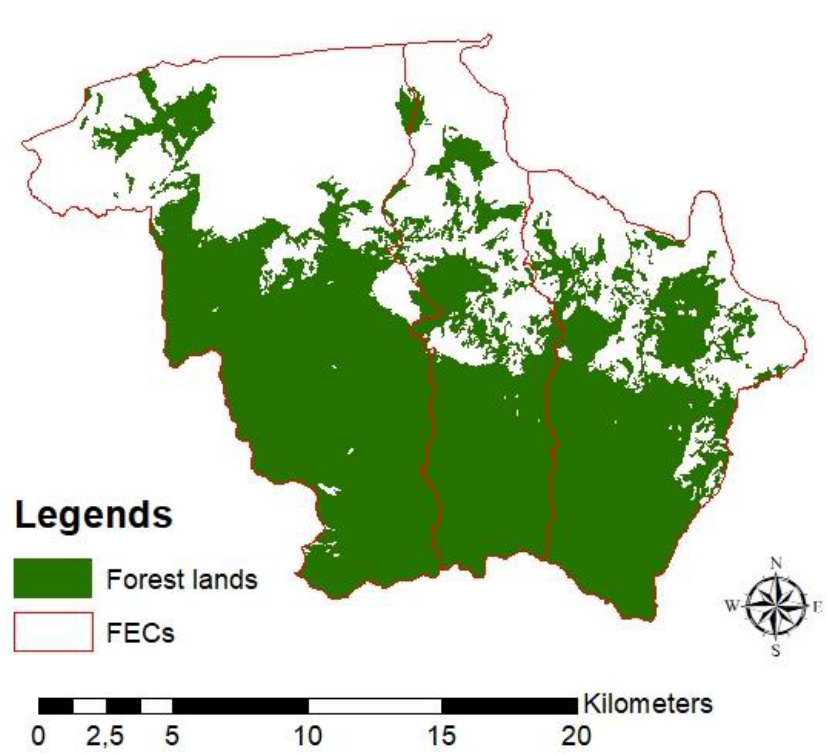
Figure 5. The map of the forest land in the study